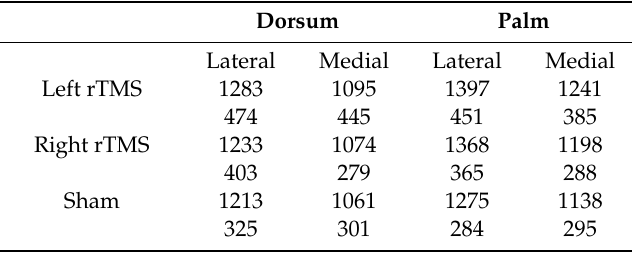
Table 4. Mean RTs (msec) and SD, separately for hand view (dorsum and palm), hand position (lateral and medial), and stimulation condition (left, right and sham). Dorsum Palm Lateral Medial